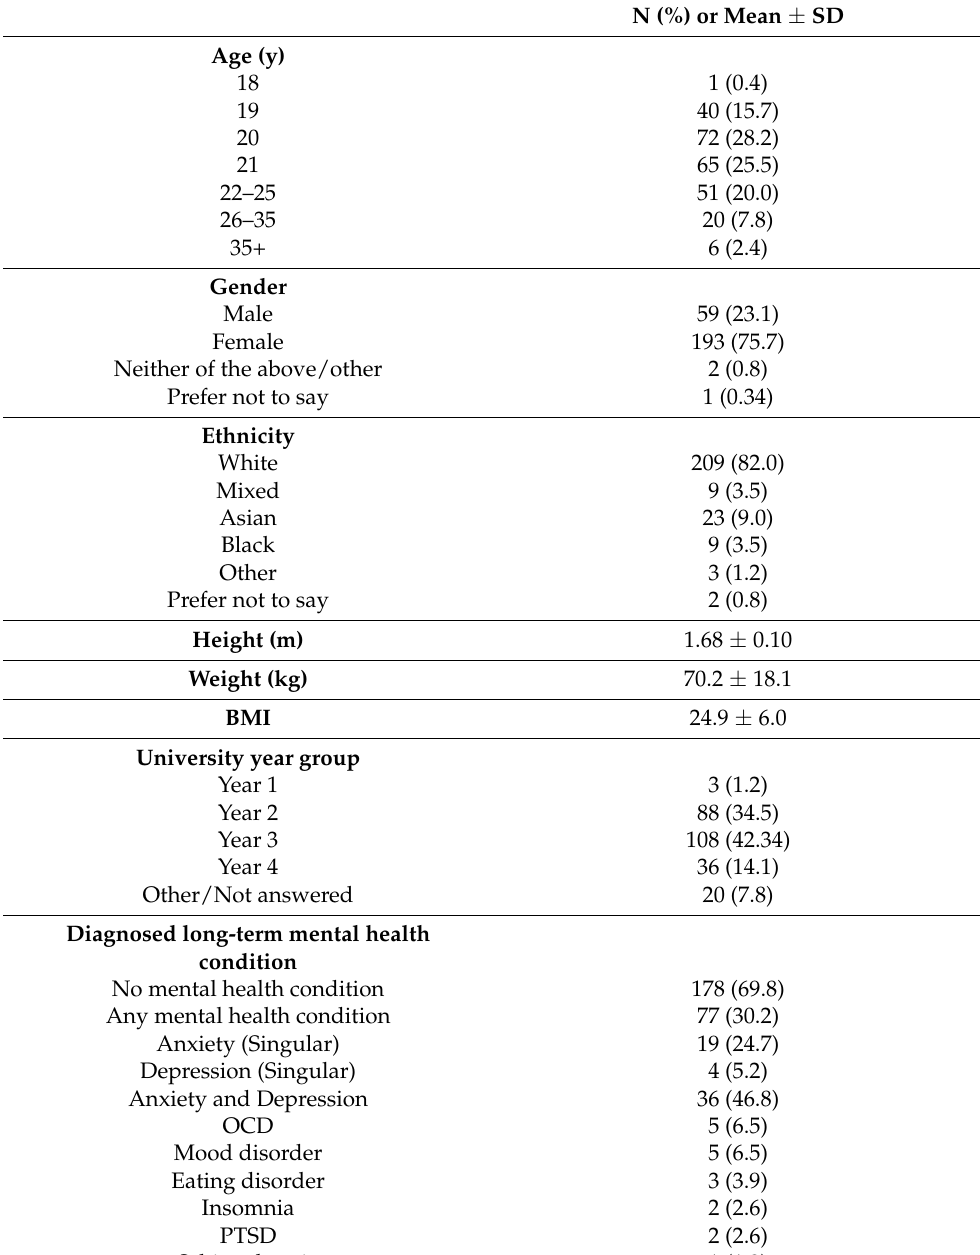
Table 1. Participant